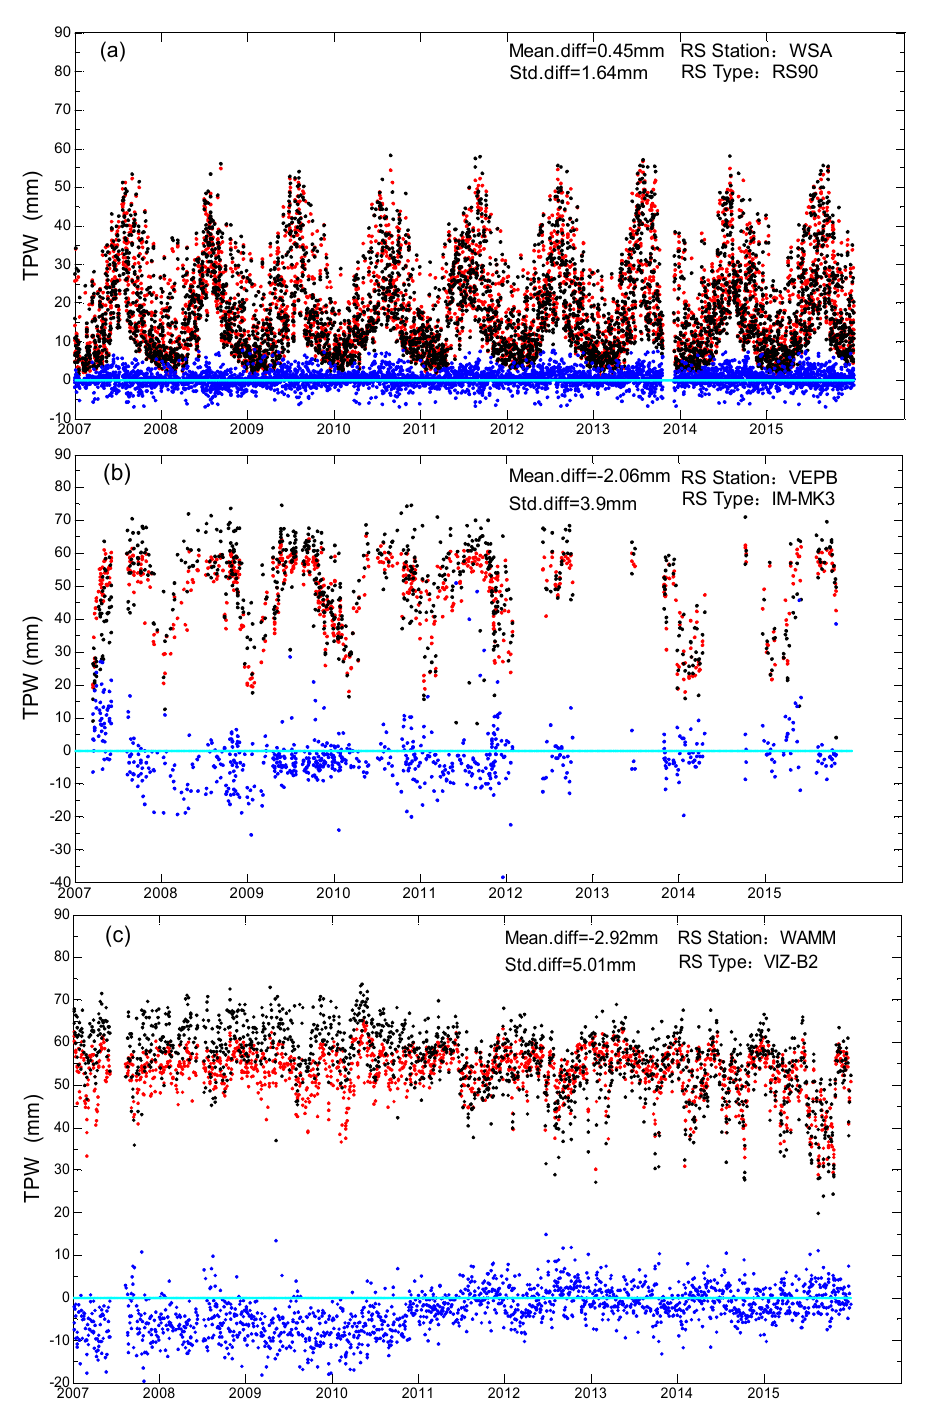
Figure 3. Time series of satellite total precipitable water (TPW), radiosonde TPW, and the differences. ( a ) for Station WSA (Sable island), ( b ) for Station VEPB (Blair), ( c ) for Station WAMM (Menado). Red dots represent satellite TPW retrievals; black dots represent TPW of radiosonde; blue dots represent the difference between them (the former minus the later); light blue lines represent zero. Mean di ff erence, standard deviation of di ff erences, as well as name and radiosonde type of each radiosonde station are marked on each